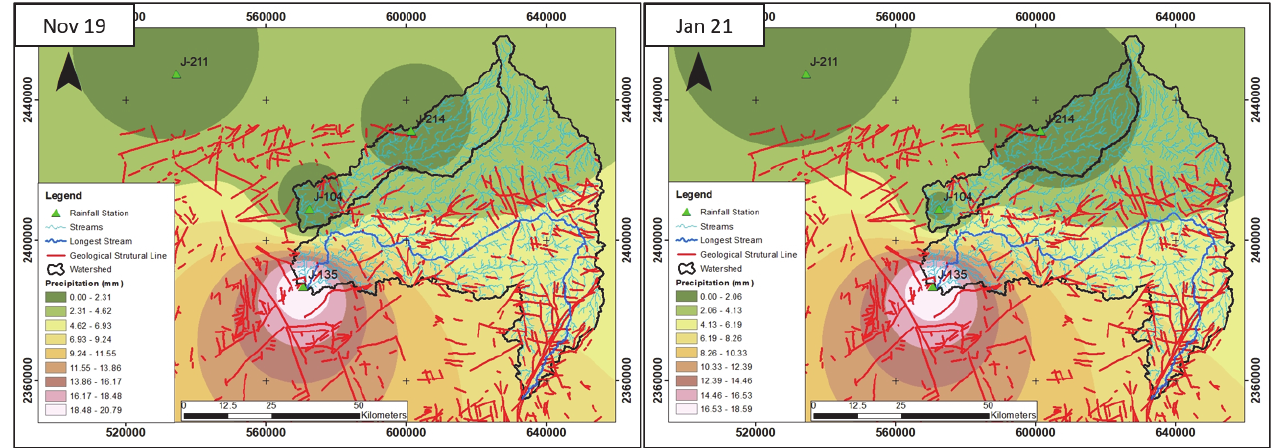
Figure 24. The rainfall contours projected over the fractures map to show the potential extra recharge from the southern watershed into Al-Lusub watershed in the downstream area. 2. Rainfall at upstream is lower than the rainfall at the surrounding area (Figure 24).